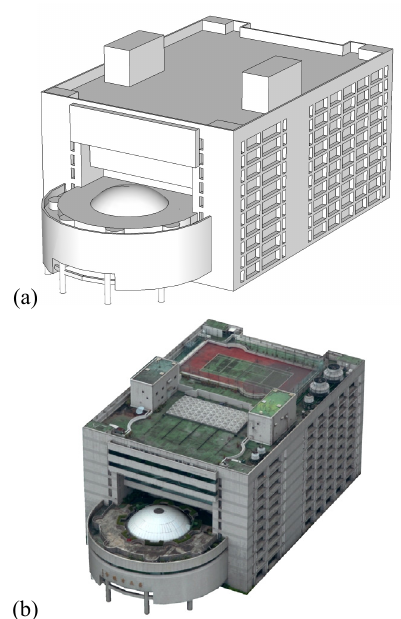
Figure 13. Highly detailed model after editing (a) monochrome output (b) textured with raw